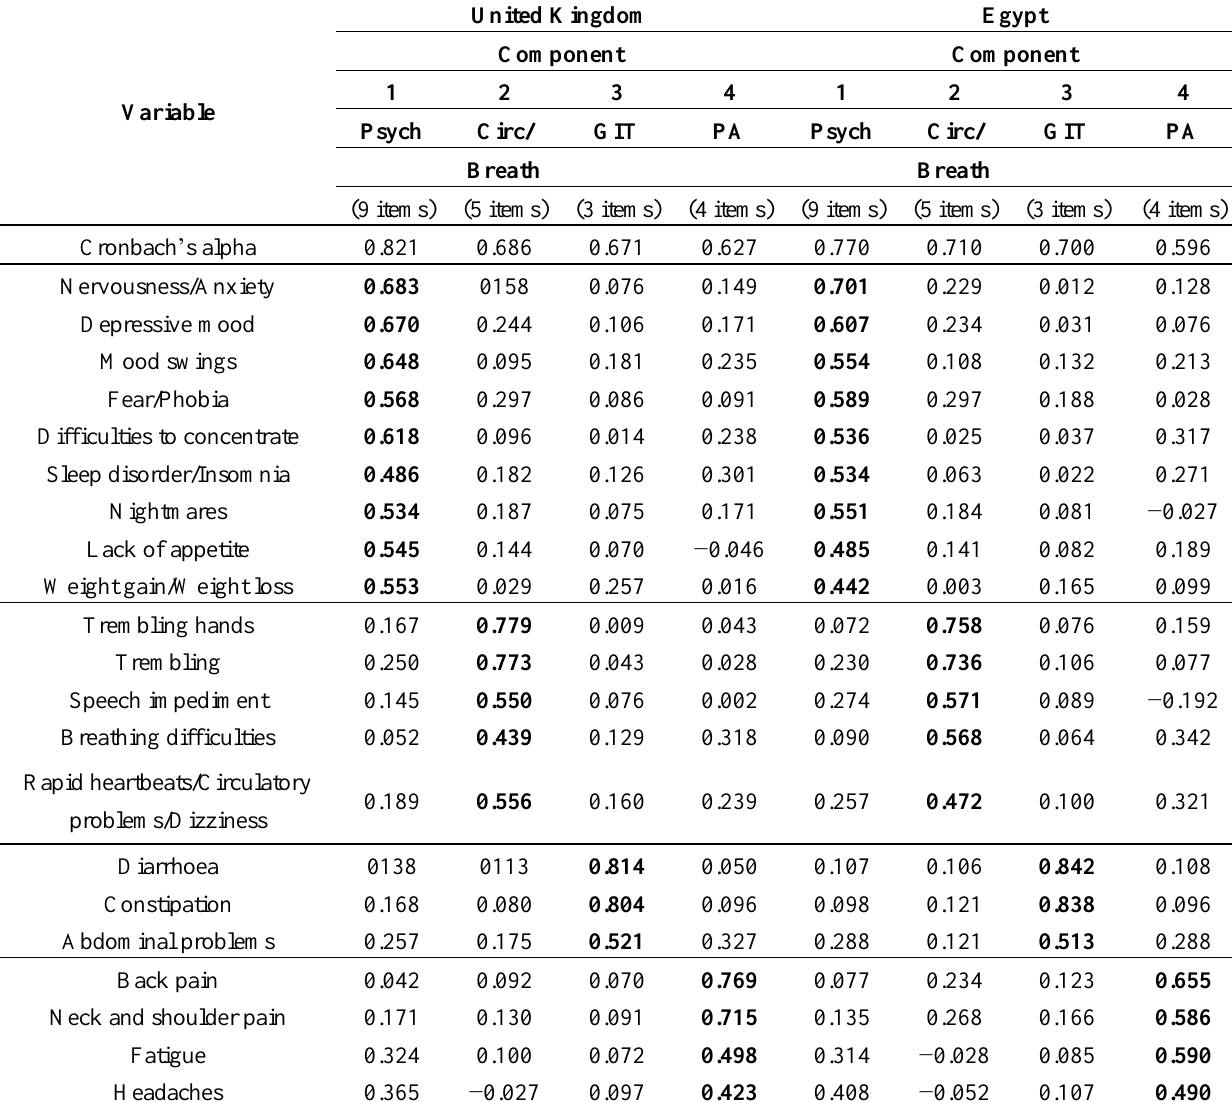
Table 2. Factor analysis of 21 self-reported symptoms/health complaints into four components for the UK and